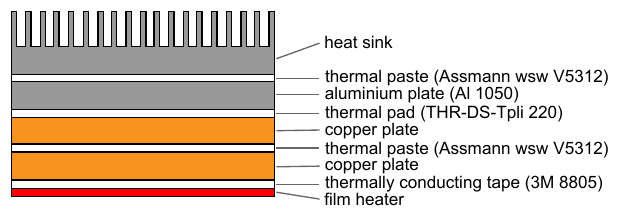
Figure 6. Cross-section of a heater